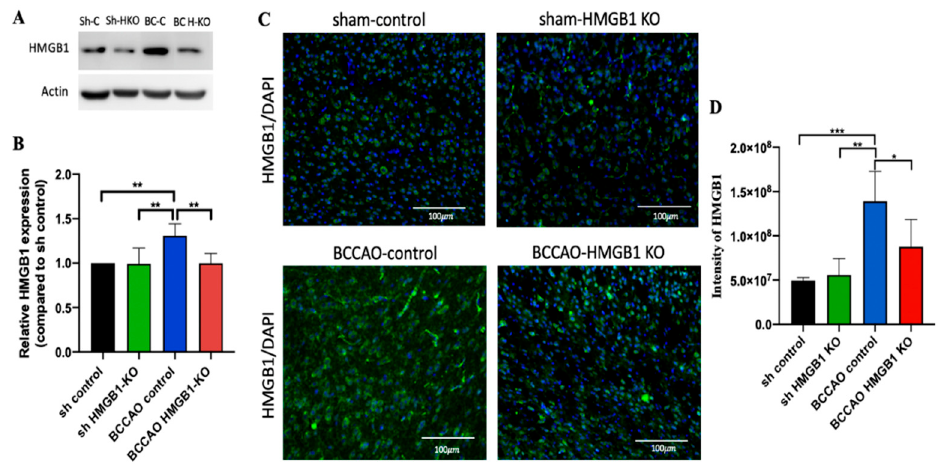
Figure 4. After injection of the HMG-1 CRISPR/Cas9 knockout (KO) plasmid, high-mobility group box protein 1 (HMGB1) expression in the cortex and hippocampus was suppressed, as confirmed through Western blot and immunostaining. ( A ) Western blot showed a decrease in HMGB1 expression in bilateral common carotid artery occlusion (BCCAO) HMGB1-KO mice compared with BCCAO controls. ( B ) Quantification data of Western blot results. ( C ) Immunostaining further confirmed the Western blot finding that HMGB1 expression decreased in the cortex of BCCAO HMGB1-KO mice but not in BCCAO controls. ( D ) Quantification data of immunostaining image. n = 5 for each group. Data are presented as the mean + standard deviation; * p < 0.05; ** p < 0.01; *** p < 0.001 with